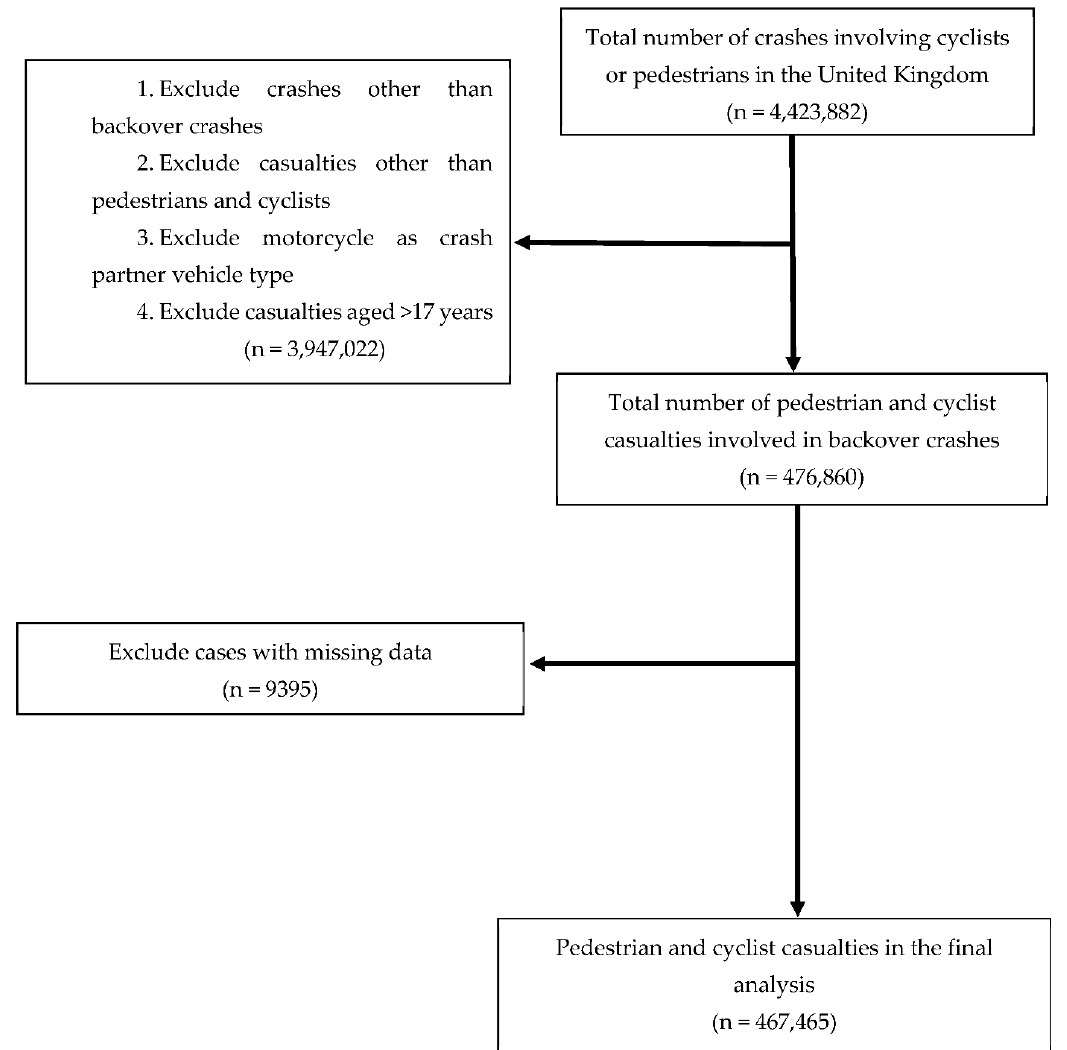
Figure 1. Sample selection process.